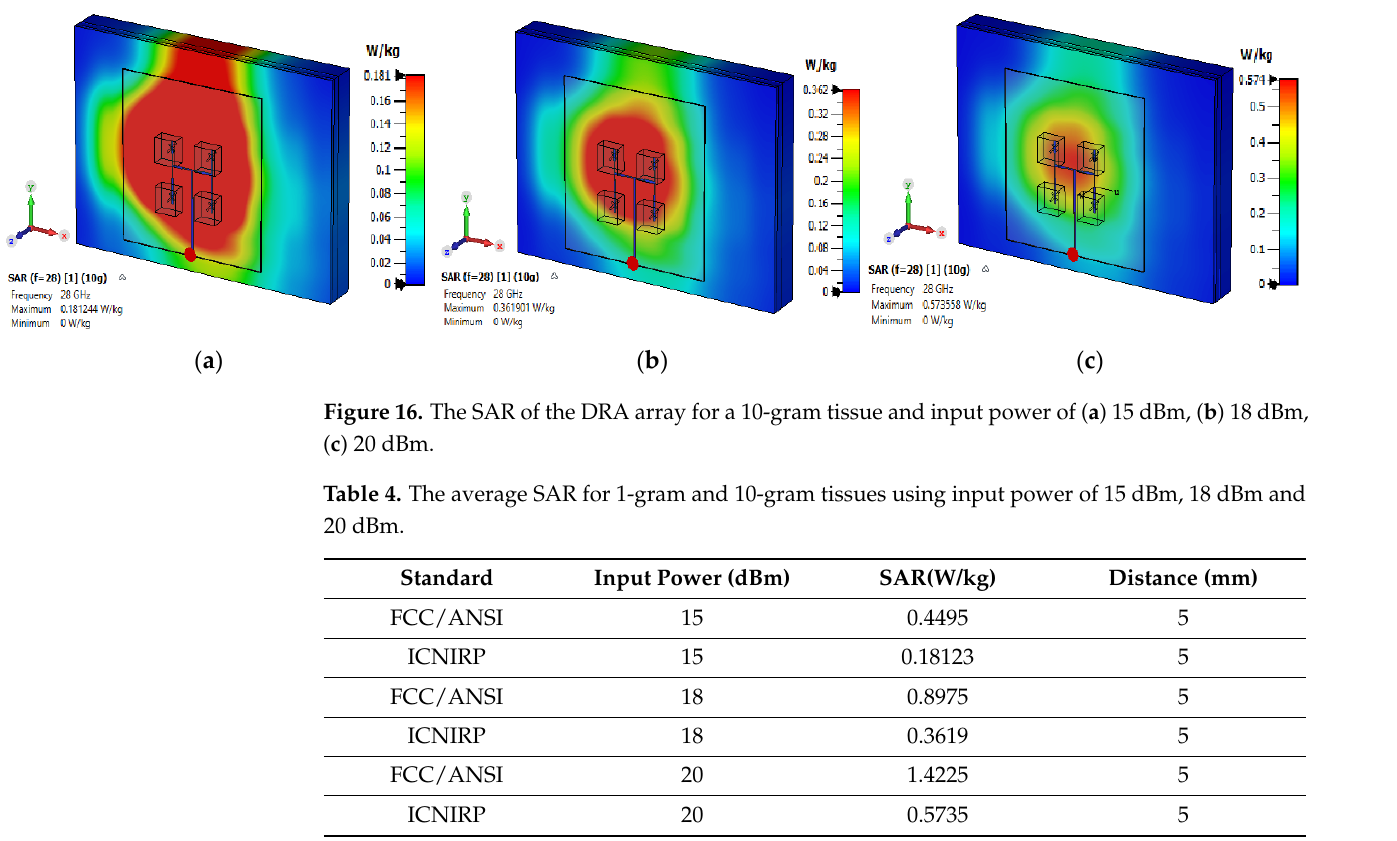
Figure 15. The SAR of the DRA array for a 1-gram tissue and input power of ( a ) 15 dBm, ( b ) 18 dBm, ( c ) 20 dBm.